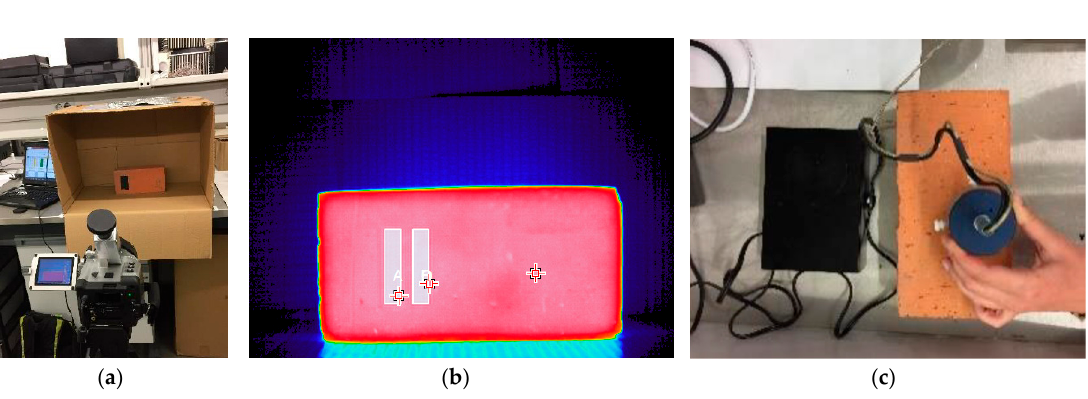
Figure 1. ( a ) Experimental set-up; ( b ) Thermal image of the ceramic brick;( c ) measurement with the